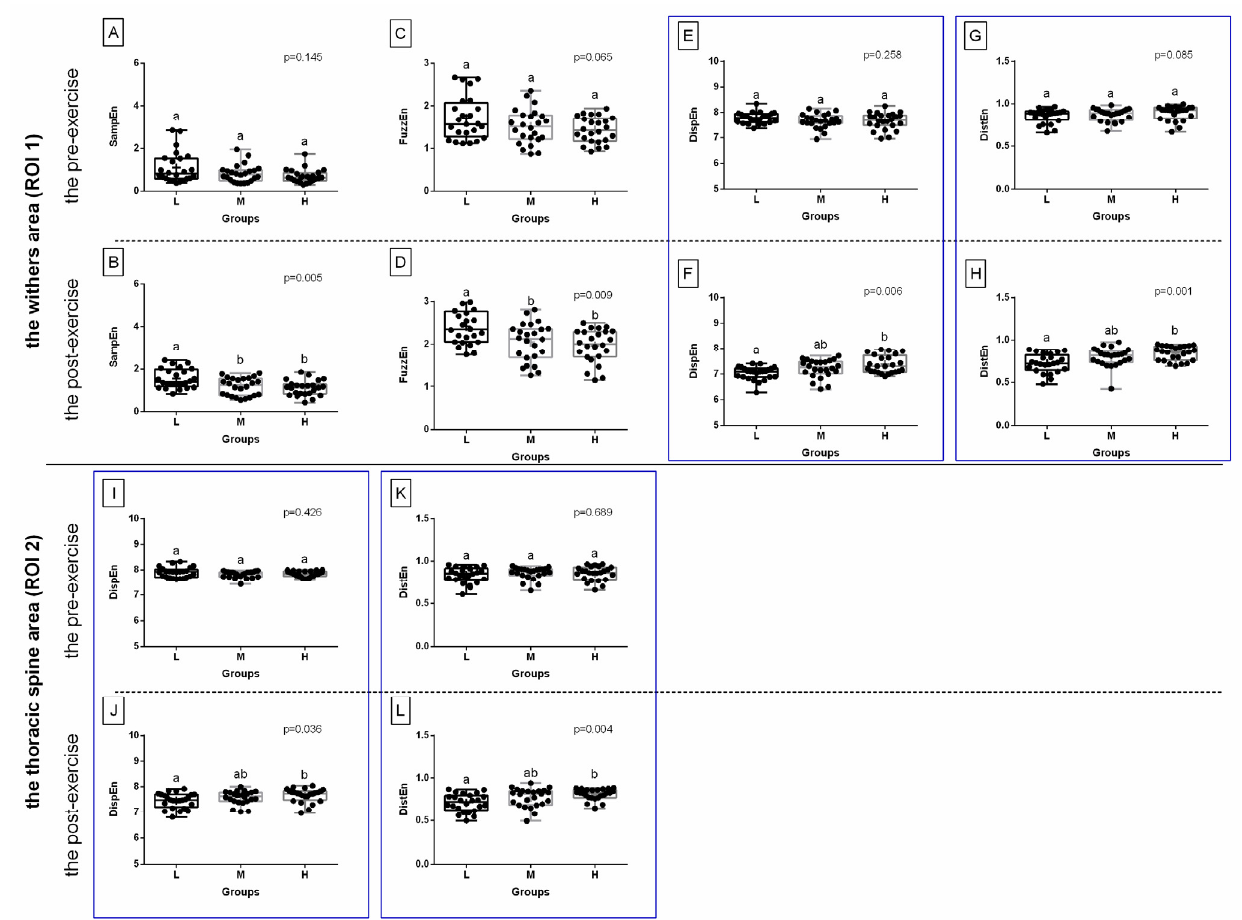
Figure 5. The comparison of the selected entropy measures in the blue color component between light (L), moderate (M), and heavy (H) rider groups. The withers area (ROI 1) ( A – H ) and the thoracic spine area (ROI 2) ( I – L ) are separated by a solid horizontal line. The images obtained pre-exercise ( A , C , E , G , I , K ) and post-exercise ( B , D , F , H , J , L ) are separated by dashed horizontal lines. The following entropy measures are considered: SampEn—two-dimensional sample entropy ( A , B ), FuzzEn—two-dimensional fuzzy entropy ( C , D ), DispEn—two-dimensional dispersion entropy ( E , F , I , J ), DistEn—two-dimensional distribution entropy ( G , H , K , L ). Data are presented using minimum and maximum values, lower and upper quartiles, and median. The mean value is marked by a cross. Differences between rider groups were indicated with individual p -values when p < 0.05. Different superscripts on each plot were statistically different. Measures that differ between rider groups (L, M, H) are marked with a blue frame.